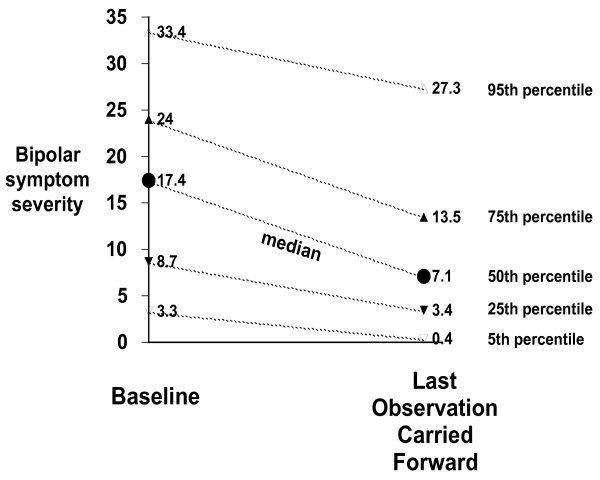
Bipolar symptom severity at Baseline and at Last Observation Carried Forward: Median and Other Percentiles; Primary Sample.